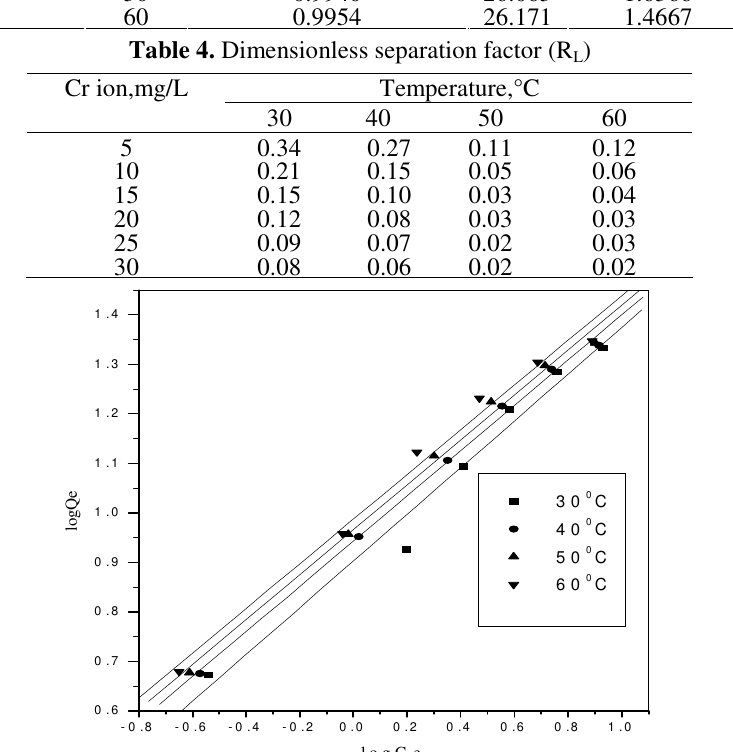
Table 4. Dimensionless separation factor (R